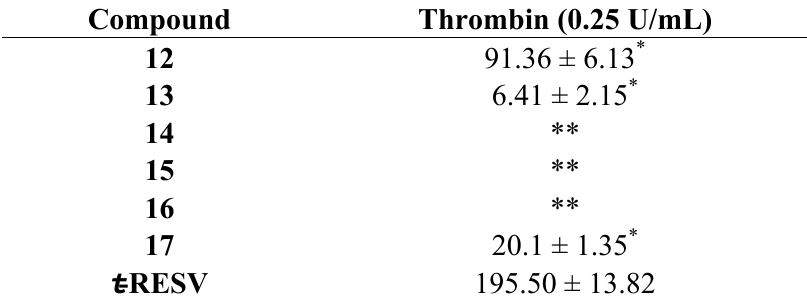
in μ M) for tested 50